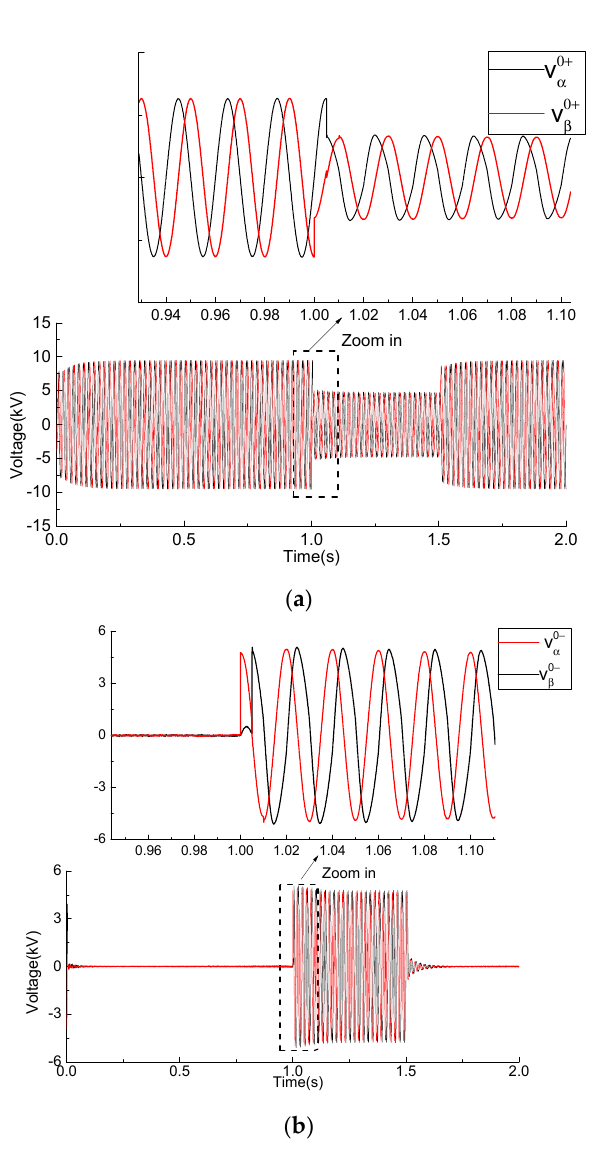
Figure 17. Positive and negative sequence components of the secondary side system voltage in the αβ